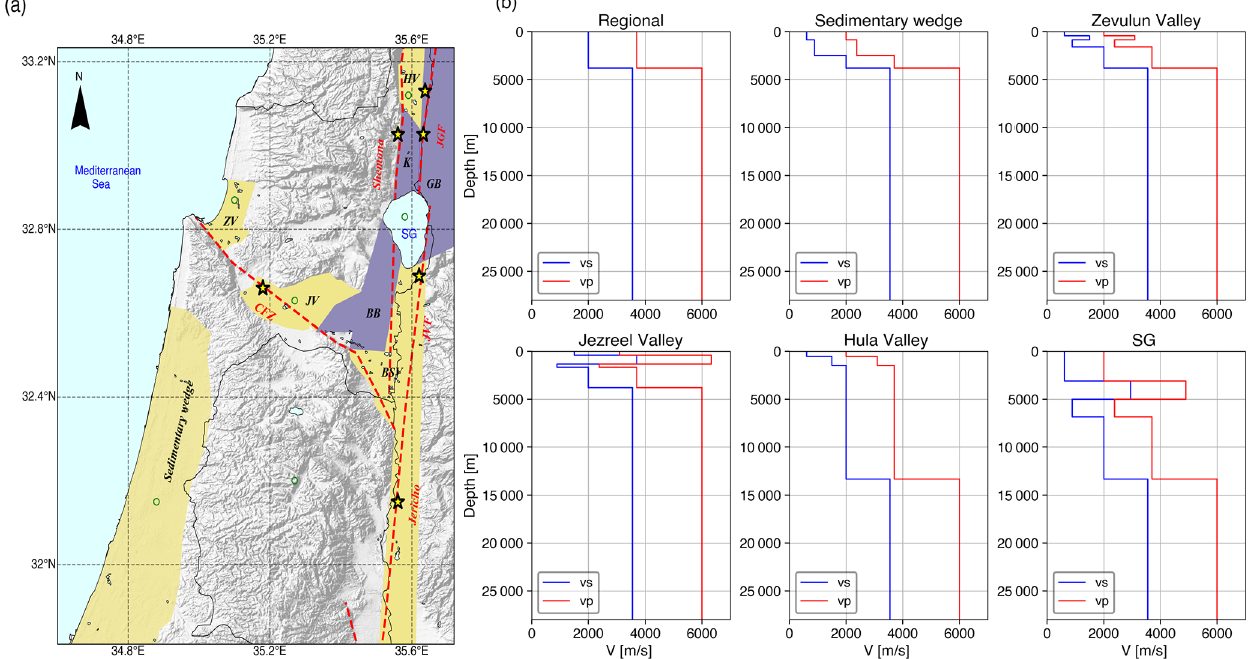
Figure 3. (a) The DST fault system and the Carmel Fault Zone (CFZ) and accompanying structures. Sedimentary structures (yellow): BSV – Beit Shean Valley, ZV – Zevulun Valley, JV – Jezreel Valley, HV – Hula Valley, SG – Sea of Galilee, and the sedimentary wedge; and hard rock structures (purple): K – Korazim structural saddle, BB – Belvoir basalts, and GB – Golan basalts. The yellow stars indicate the epicenter of the seismic sources simulated in our work: Jordan Gorge Fault (JGF), with bilateral and unilateral slip realization, Jordan Valley Fault (JVF), Jericho Fault, Shemona Fault (only for M 7), and CFZ (only for M 6). (b) Representative depth velocity profiles of the computational domain (green